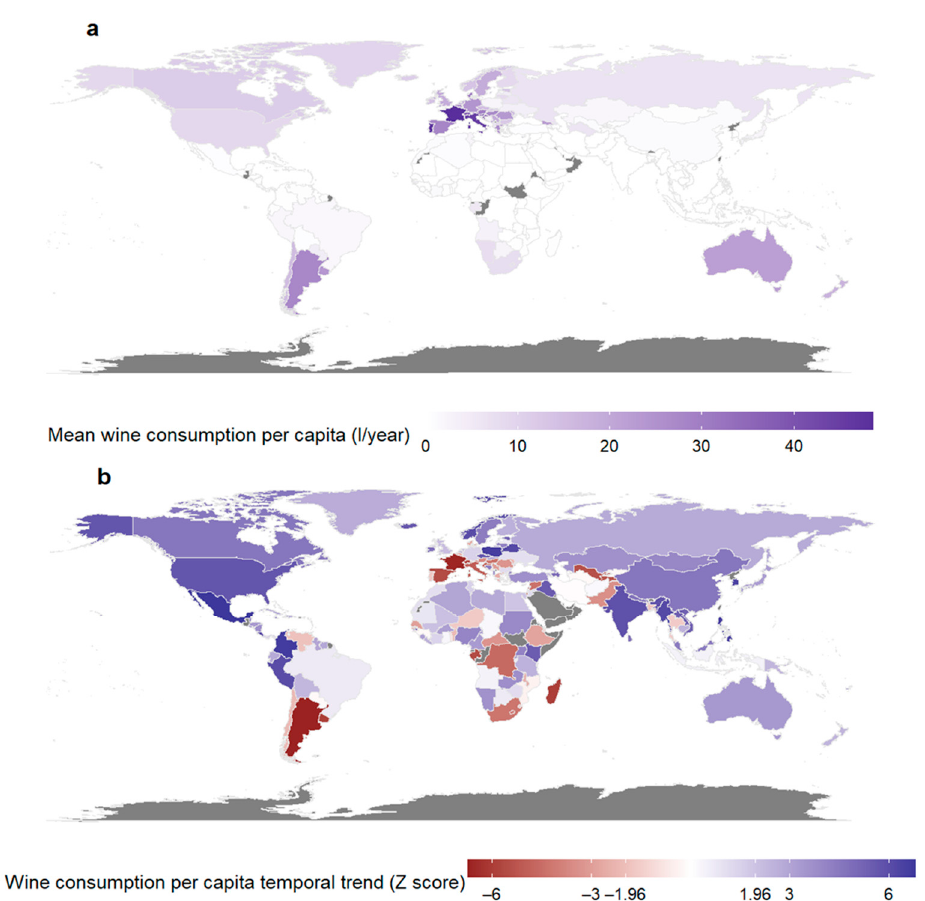
Figure 3. Wine consumption per capita representation for each country, including mean long-term quantities ( a ); and Z-score for each country, signifying the extent of the temporal trend over 27 years ( b ). Countries in grey represent no data.